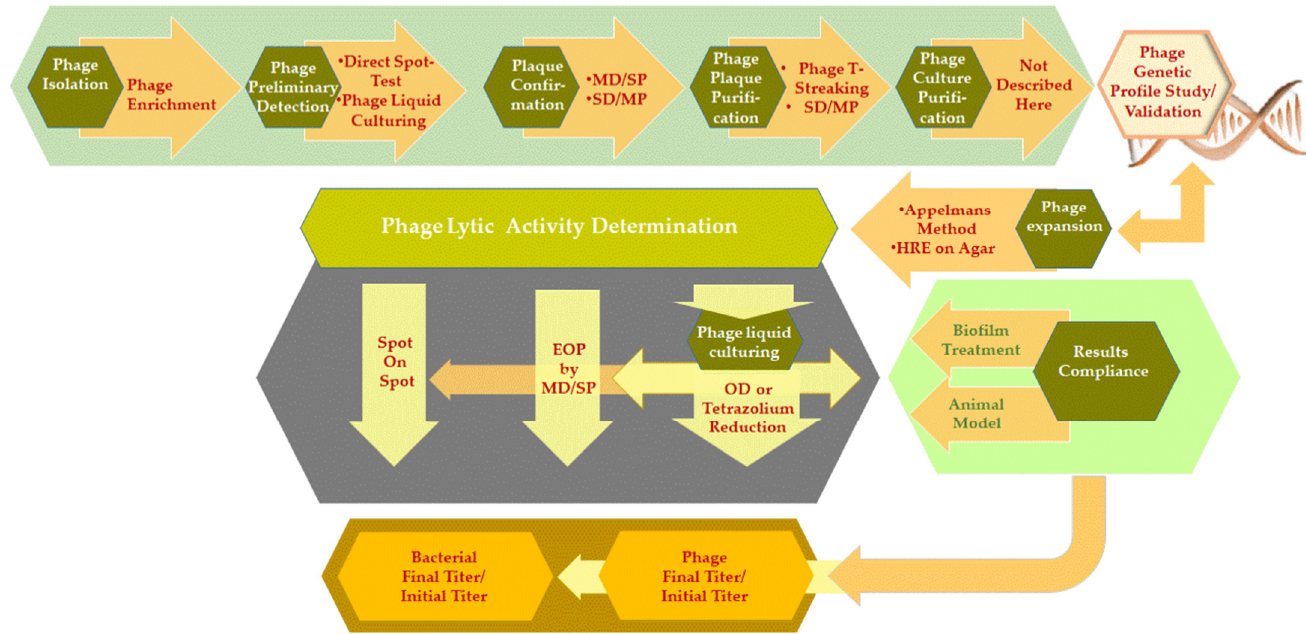
Figure 1. Scheme depicting the chain of methods from phage isolation to study of compliance for phage treatment with in vitro activity evaluations. phage treatment with in vitro activity